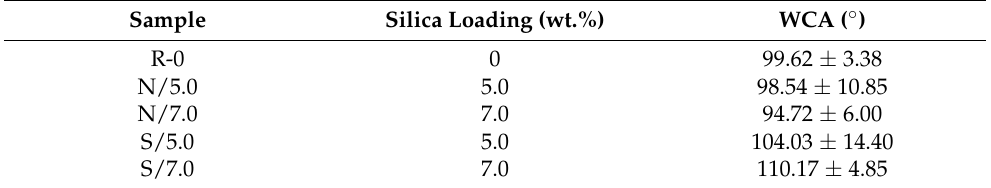
Table 1. WCA of PU coatings with varied loadings of silica nanoparticles prepared using the blending- spraying coating method.